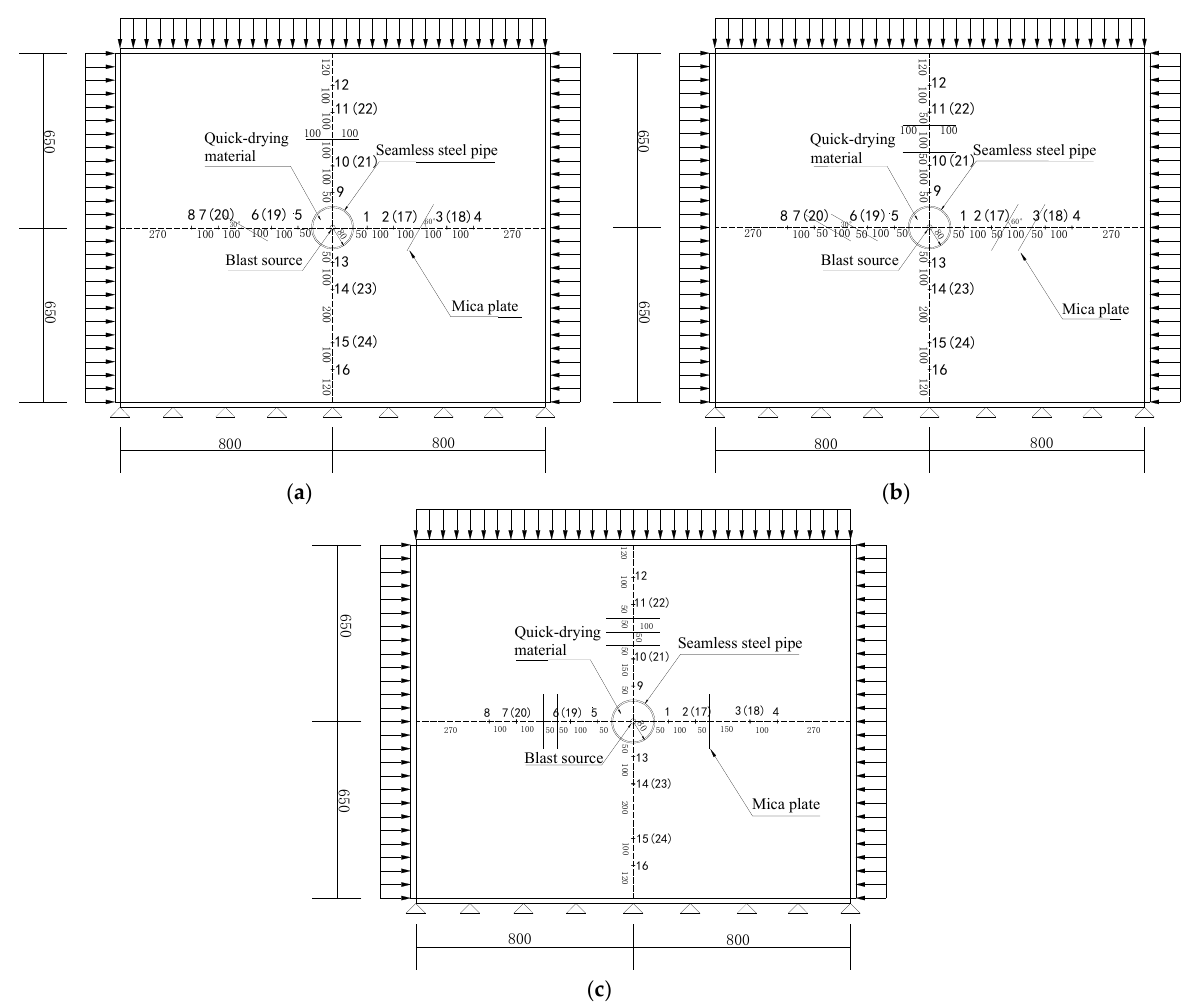
Figure 2. Layout of the measuring points and the joints of the model test samples (unit: mm): ( a ) T1 sample; ( b ) T2 sample; ( c ) T3 sample. The T1 and T2 samples were designed to study the propagation of the blasting stress waves in intact rock, and the normal or oblique impact of the blasting stress wave on the rock mass containing joints with a different number and angle, and